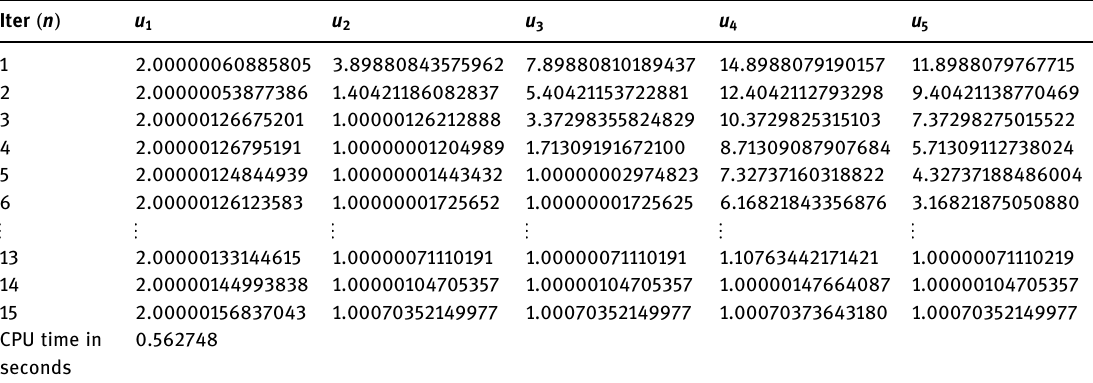
Table 3: Example 5.2: Numerical study of Algorithm 1 with TOL = 10 −4 and